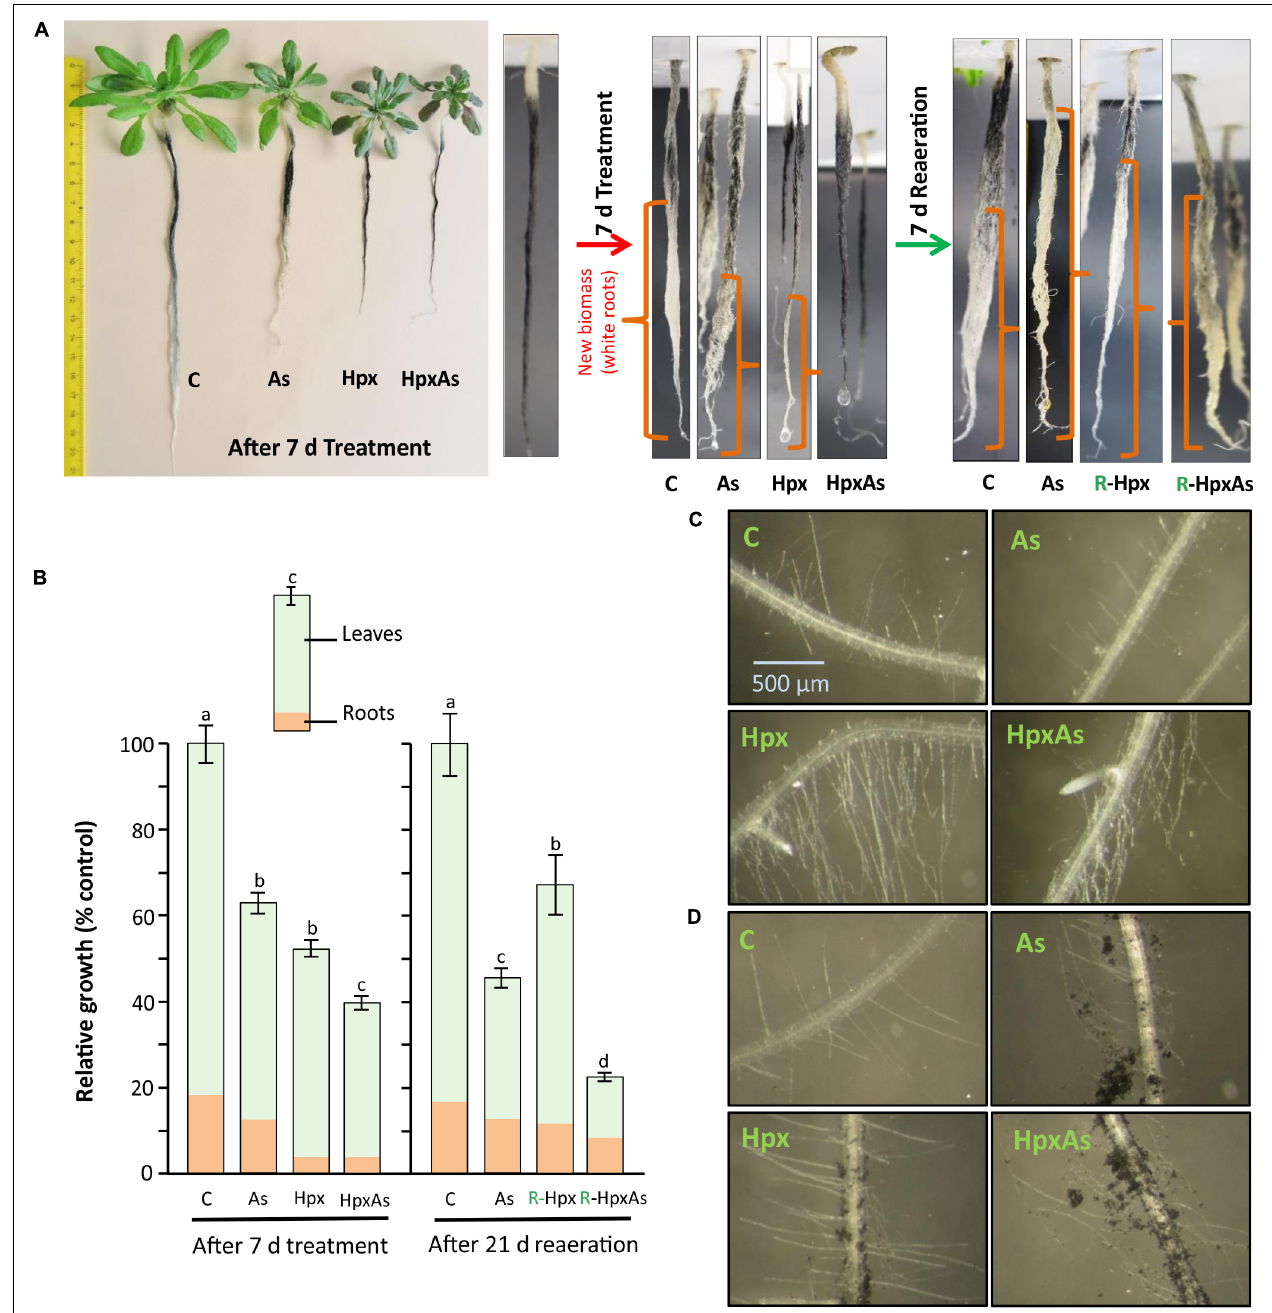
FIGURE 1 | Root and root hair phenotype of plants exposed to arsenic (As), hypoxia (Hpx) and their combination (HpxAs). A . thaliana plants were grown for 32 days in hydroculture and then exposed to As (V; 250 µ M), Hpx or their combination (HpxAs) for 7 days. (A) Plant images (left panel) after 7 days of treatment for comparison of treatment effects on root and shoot growth. Just before the start of treatment and start of reaeration, plant roots were stained with active charcoal. The strong surface adherence of charcoal particles allows assessment of fresh root growth during treatment and reaeration, which appear white. Close-up images of roots (middle) highlight newly formed root biomass after 7 days treatment. In these close-up images roots are not in scale for comparison of total root length however can be compared qualitatively for extent of growth (in different root zones) among different treatments (white color). Also shown are images of stained roots (right) that were reaerated for 7 days after treatment (supplemented with aerated nutrient media; supplemented with As(V) in case of HpxAs-treatment). (B) Data on relative total biomass accumulation (shoot and root visible) after 7 days of treatment (means ± SE, n = 40; 3 independent experiments; Tukey’s test, p < 0.05) and long reaeration (21 days) (means ± SE, n = 12; Tukey’s test, p < 0.05). Further, images of the RH zone under different treatments without (C) or with (D) charcoal staining after 7 days treatment.